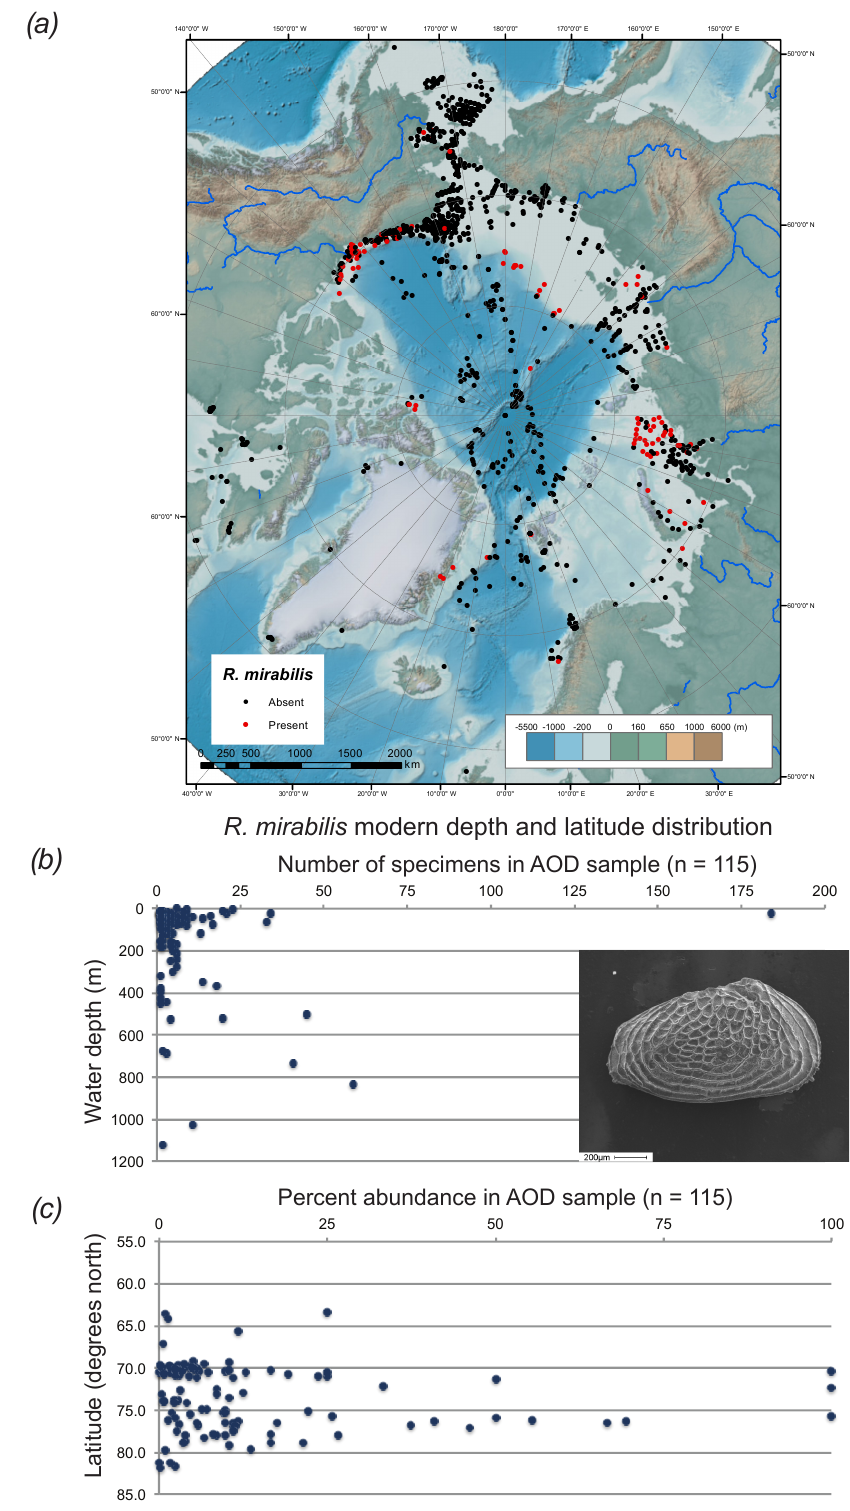
Figure 6. (a) Occurrence map of Rabilimis mirabilis in the Arctic Ocean and surrounding seas based on 1340 modern surface samples in the Arctic Ostracode Database (AOD; Gemery et al., 2015). (b) Modern depth and (c) latitudinal distribution of R. mirabilis based on 1340 modern surface samples in the AOD (Gemery et al.,